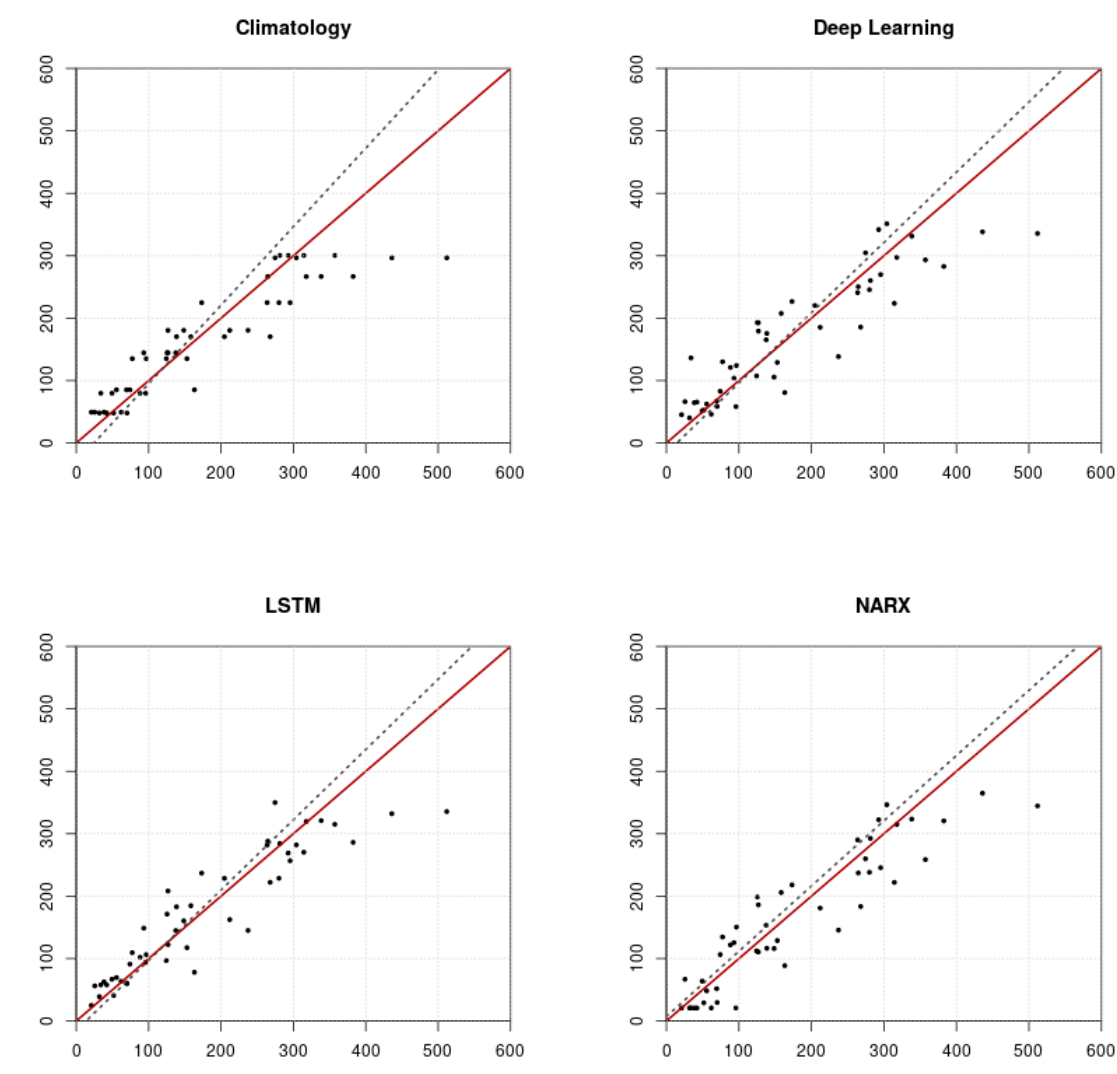
Figure 7. Scatter plot (observed values on the x-axis and forecasted values on the y-axis) of Group 3 models and climatology for a forecast horizon of 1 month for the Guavio reservoir. The red line indicates a perfect fit of observed and forecasted values, while the black dashed line corresponds to the linear regression of the observed values given the forecasted values. Table 4. Economic scenario analysis of the potential economic benefits of using SCHT with respect to the climatological average